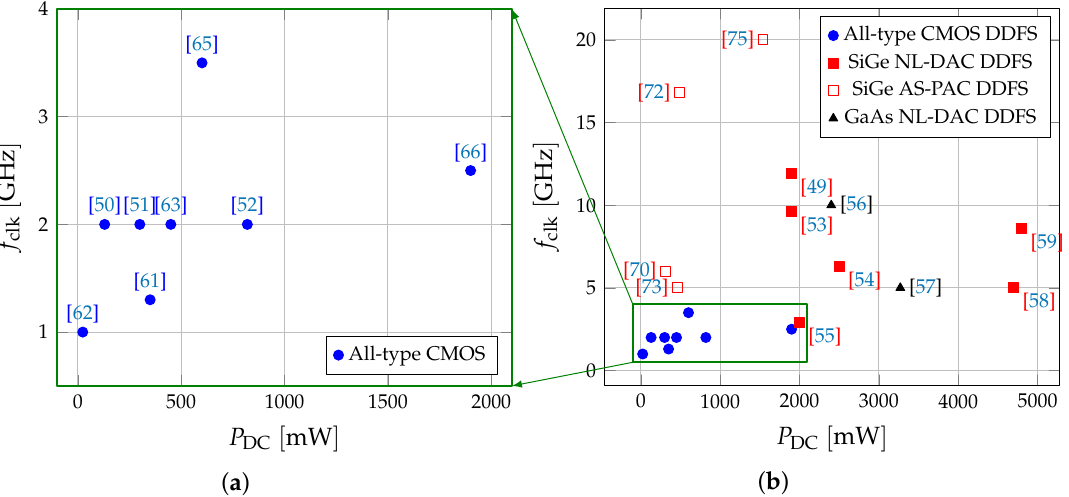
Figure 16. f clk versus consumption P DC for DDFSs in ( a ) All-type CMOS (full scale) and ( b ) All-type CMOS, an NL-DAC or AS-PAC SiGe and GaAs technologies